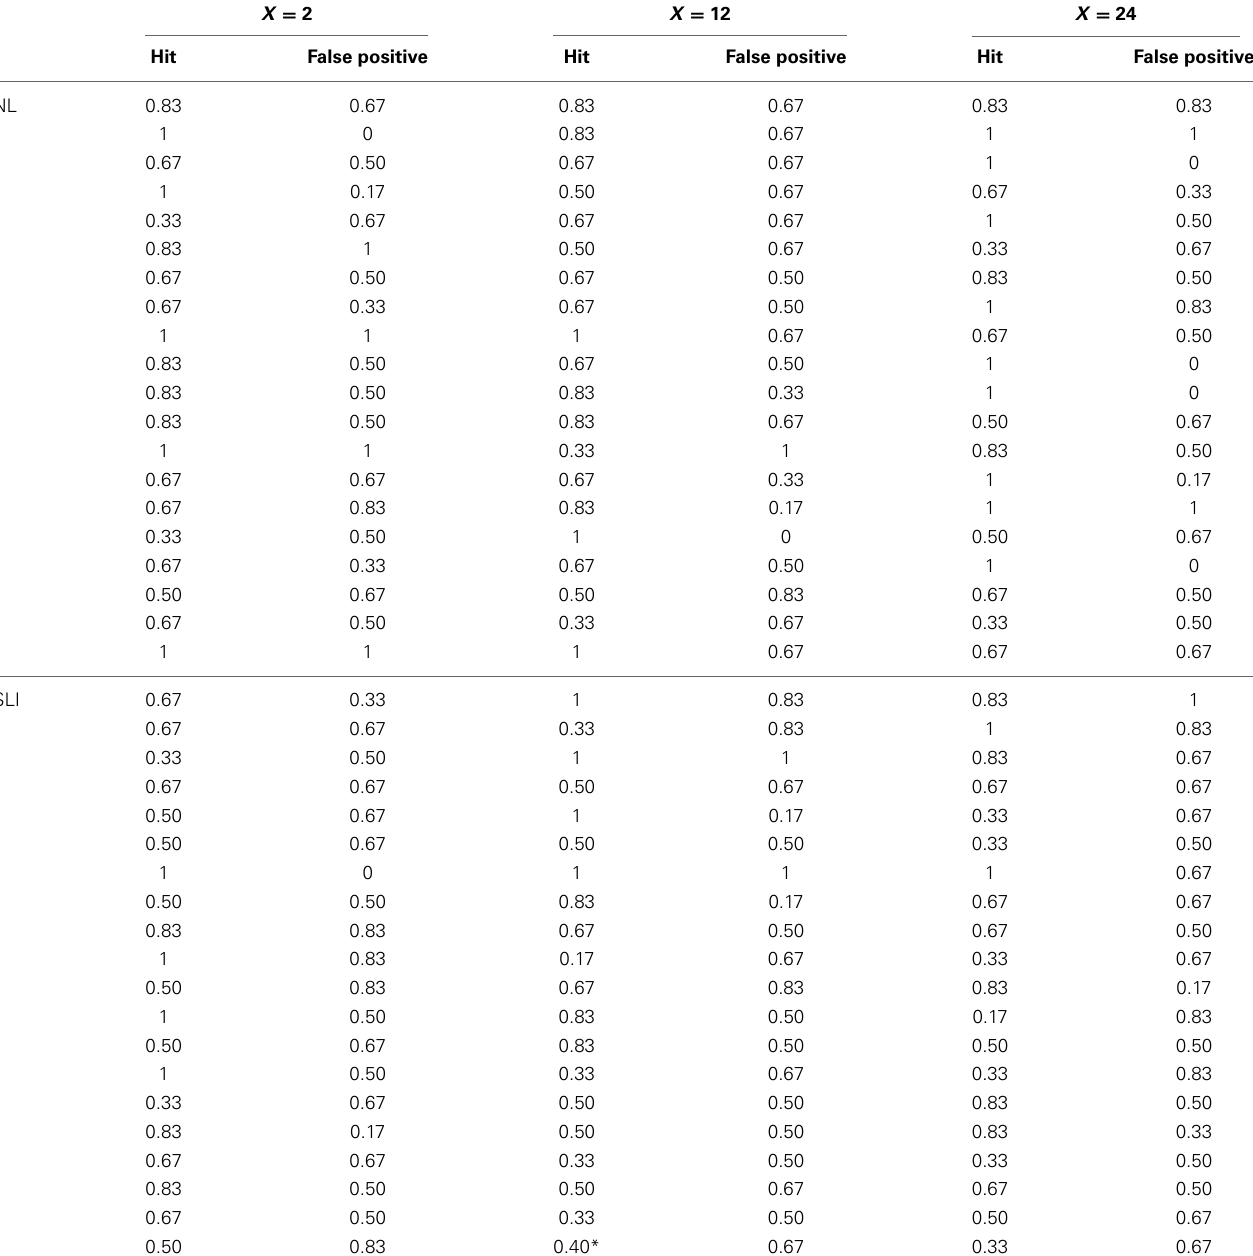
Table A1 | Hit and false-alarm rate for each participant in the three